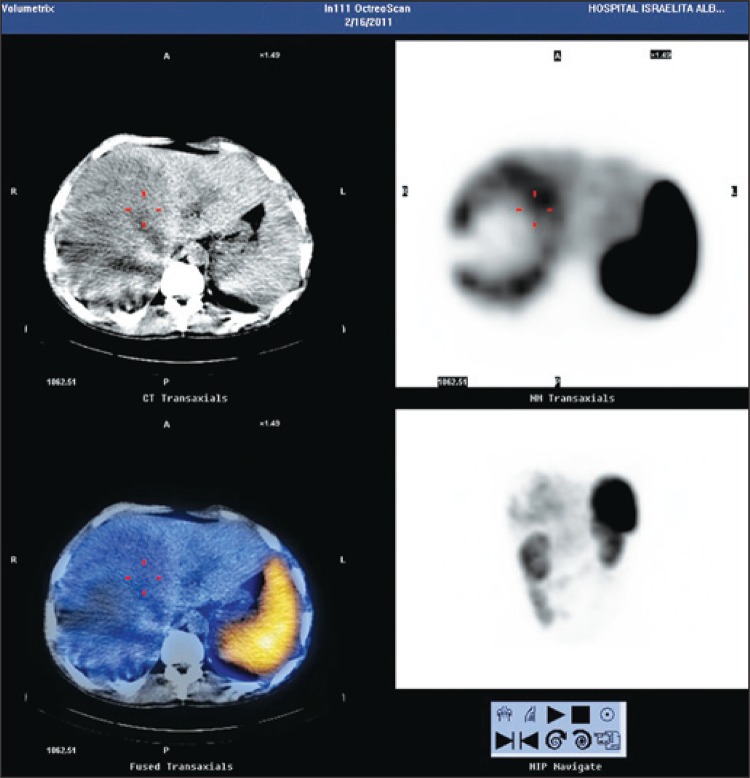
Cintilografia com ocreotide - evidenciando captação de radiofarmaco em lesão hepática